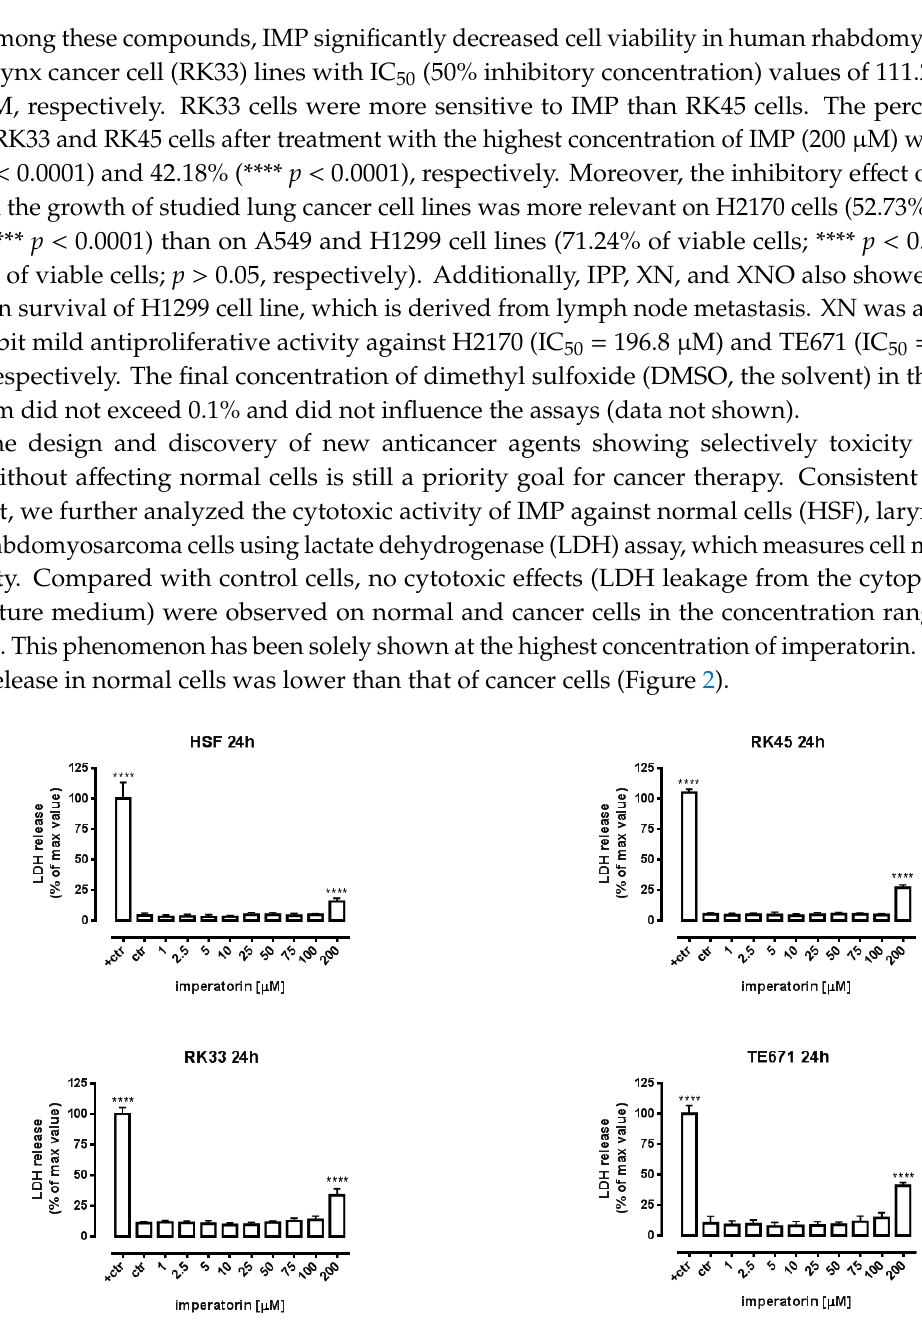
Figure 2. Cytotoxicity of imperatorin to normal human skin fibroblasts (HSFs), larynx cancer (RK33 and RK45), and rhabdomyosarcoma (TE671) cells. Lactate dehydrogenase (LDH) ELISA kit was used